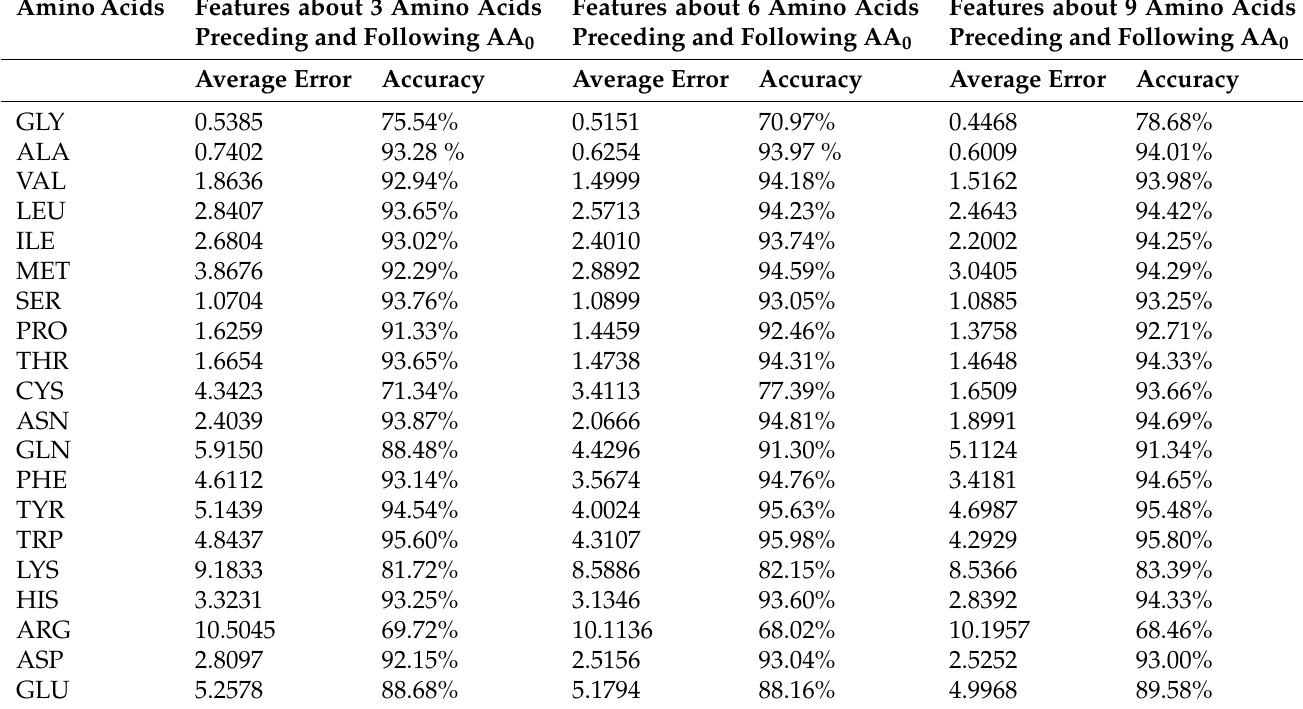
Table 1. Table showing that for every amino acids the results, in terms of accuracy and average error, were performed training the RF with the hyperparameters found with the stress